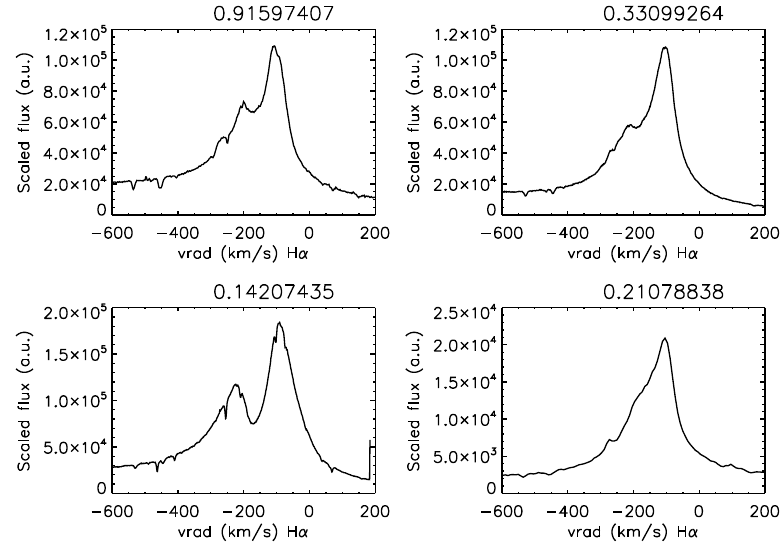
Fig. 5a. Sample profiles for H α in AG Dra from the TNG spectra at several orbital phases. The dates are JD 51826, 53151, 53589 and 54731. The phases are according to the ephemeris of Fekel et al. (2000) with ϕ = 0 p is RG inferior conjunction.